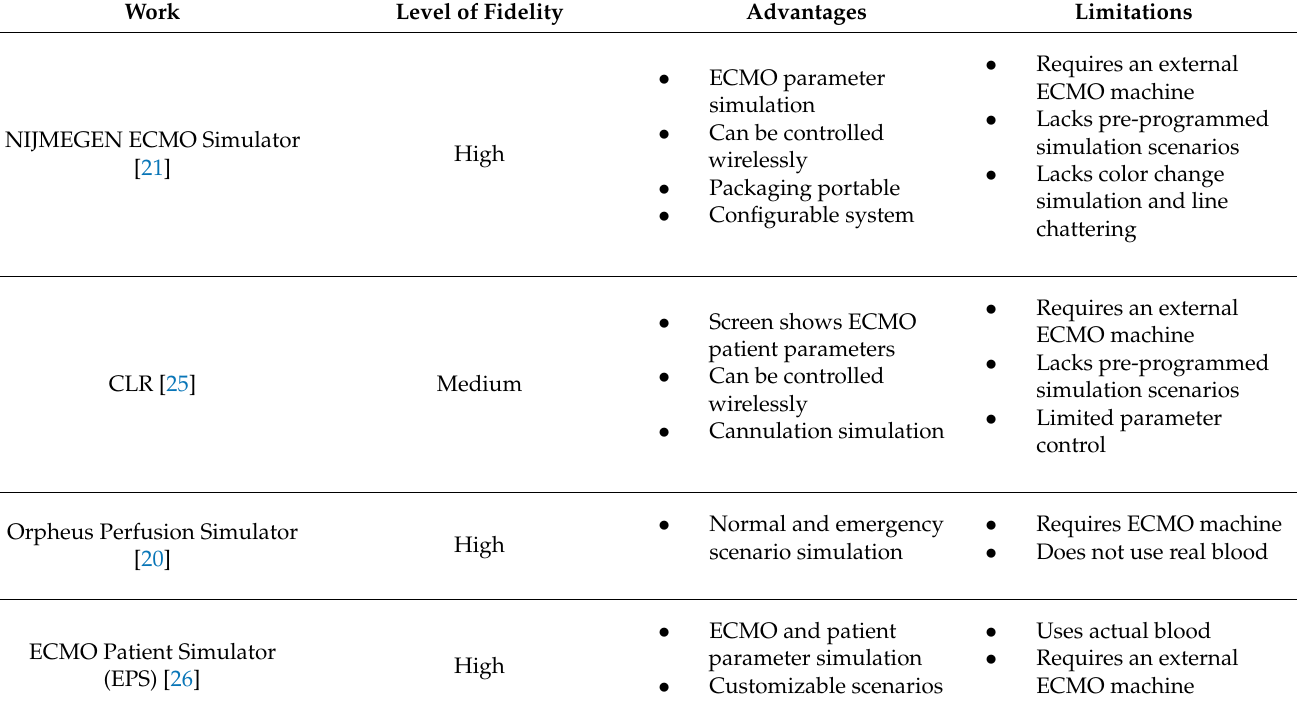
Table 1. Review of related work in ECMO